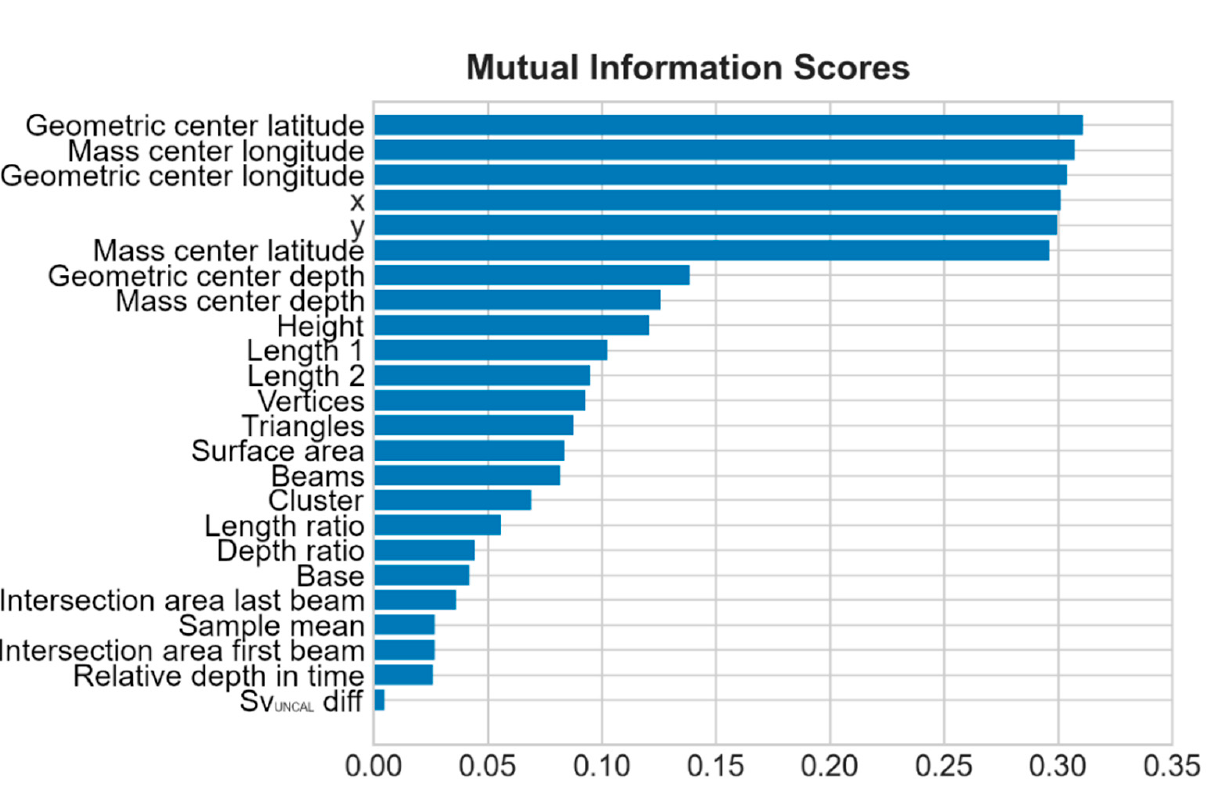
Figure 9. Feature space exploration and MI scores.